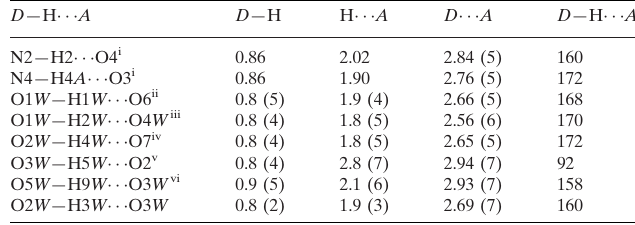
Hydrogen-bond geometry (A˚ , (cid:3)